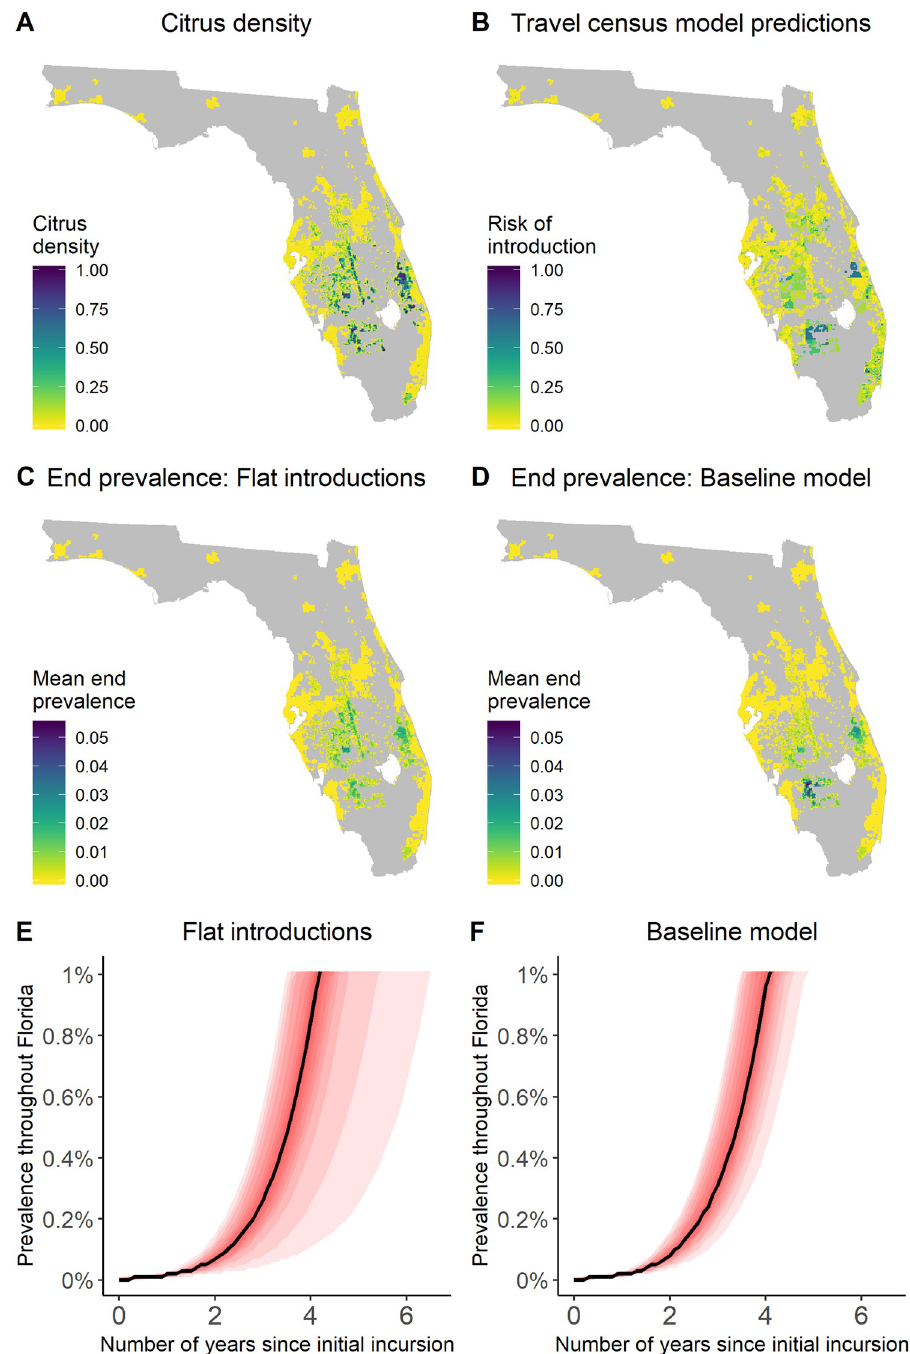
Fig 1. Simulation model upon which the optimisation is based. Plot A shows the distribution of citrus trees (which also represents the relative rate of introduction under the assumption of a ‘flat’ distribution of pathogen entry). Plot B shows the distribution of the relative risk of introduction according to the ‘travel census’ model (which is combined with the citrus density to estimate the relative distribution of introductions under the ‘variable’ model [that is, the ‘baseline’ model]). Plots C and D show the mean end prevalence if introductions are based only on citrus density (‘flat’ pathogen entry, C) or both citrus density and travel census risk (‘variable’ pathogen entry, D). Plots E and F show the 5 th –95th percentiles of the disease progression curves under each of these assumptions, with greater intensity of colouration for percentiles approaching the median (shown as a solid line). The data used to create these plots can be found at https://doi.org/10.17866/rd.salford.12759929.v1 (files ‘spatialData_baselines.csv’, ‘dpcData.csv’, and ‘dpcSummary.csv’).